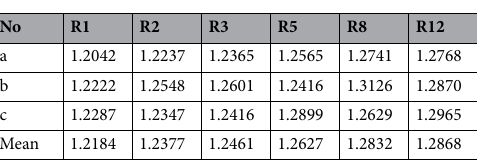
Table 6. Fractal dimension of red-bed soft rock in different water–rock interaction cycles.